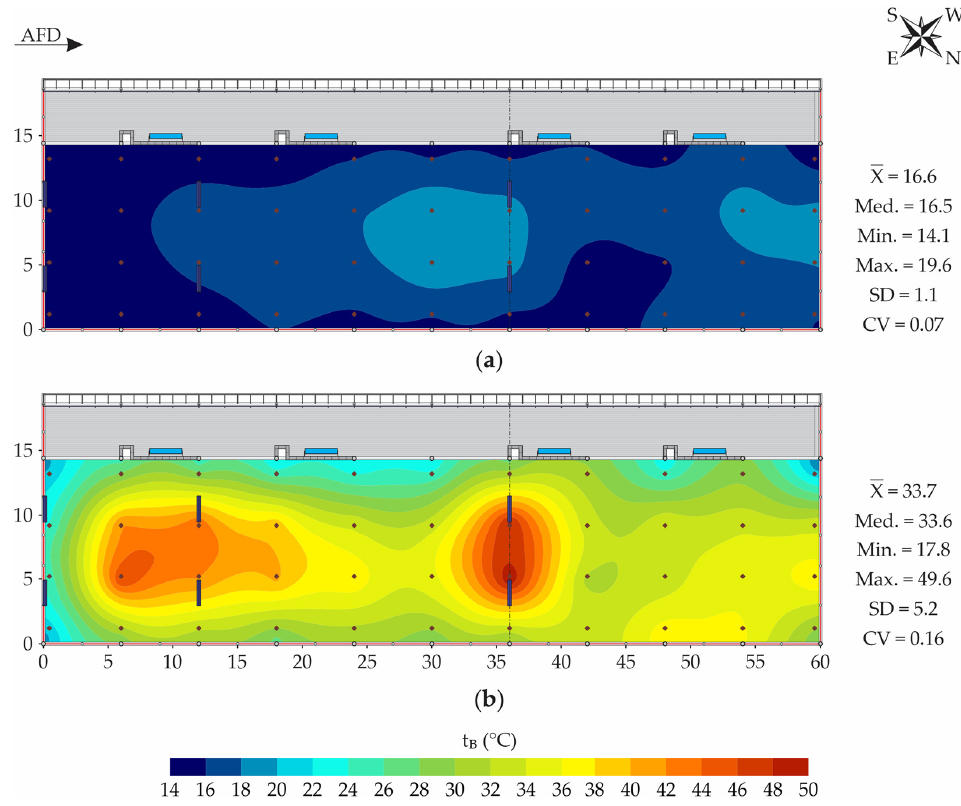
Figure 3. Spatial distribution of bedding temperature (t B , in °C) at the surface—t B-sur ( a ) and at a depth of 0.2 m—t B-20 ( b ). AFD—air-flow direction; 𝑋(cid:3364) —mean; Med.—median; Min.—minimum; Max.— a depth of 0.2 m—t B-20 ( b ). AFD—air-flow direction; X —mean; Med.—median; Min.—minimum; maximum; SD—standard deviation; CV—coefficient of variation. Max.—maximum; SD—standard deviation; CV—coefficient of